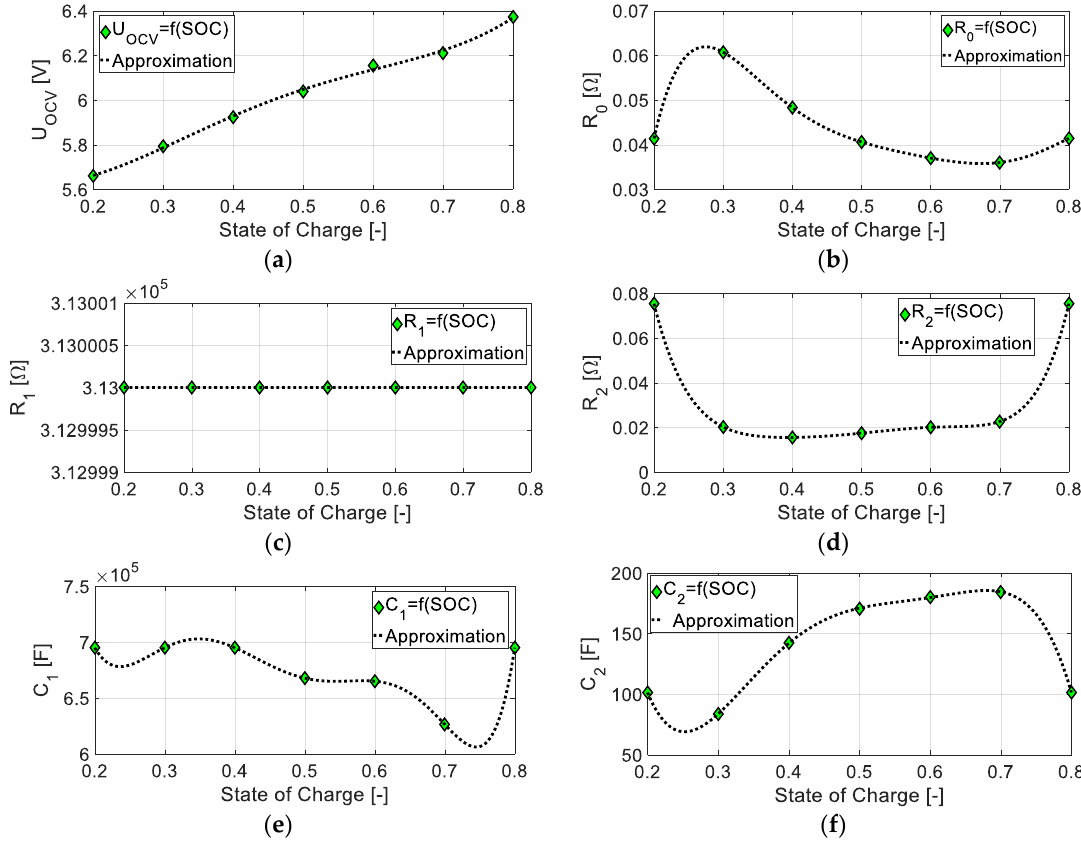
Figure 5. Graphs of the identified parameters of DP model: ( a ) U OCV ; ( b ) R 0 ; ( c ); R 1 ; ( d ) R 2 ; ( e ) C 1 ; ( f ) C 2 for State of Charge (SOC) ranging from 0.2 to 0.8 in pulse work cycle.